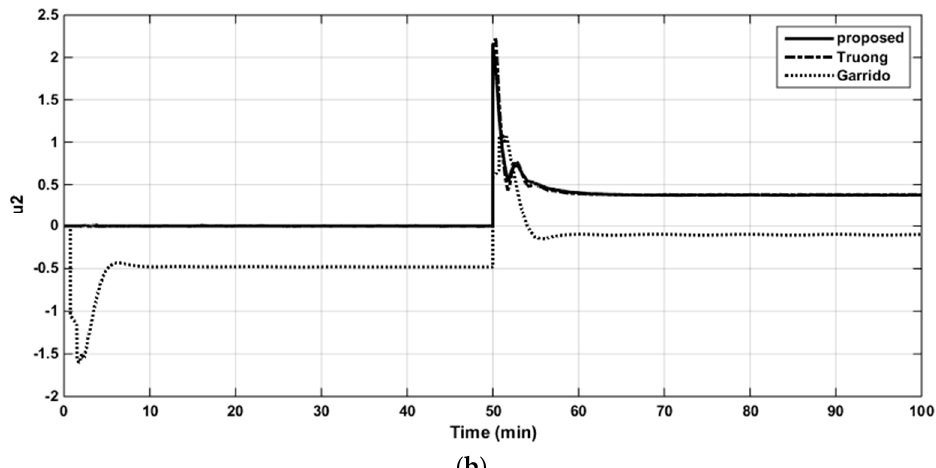
Figure 16. The control signal in loop 1 of the VL column ( a ). The control signal in loop 2 of the VL column ( b ).